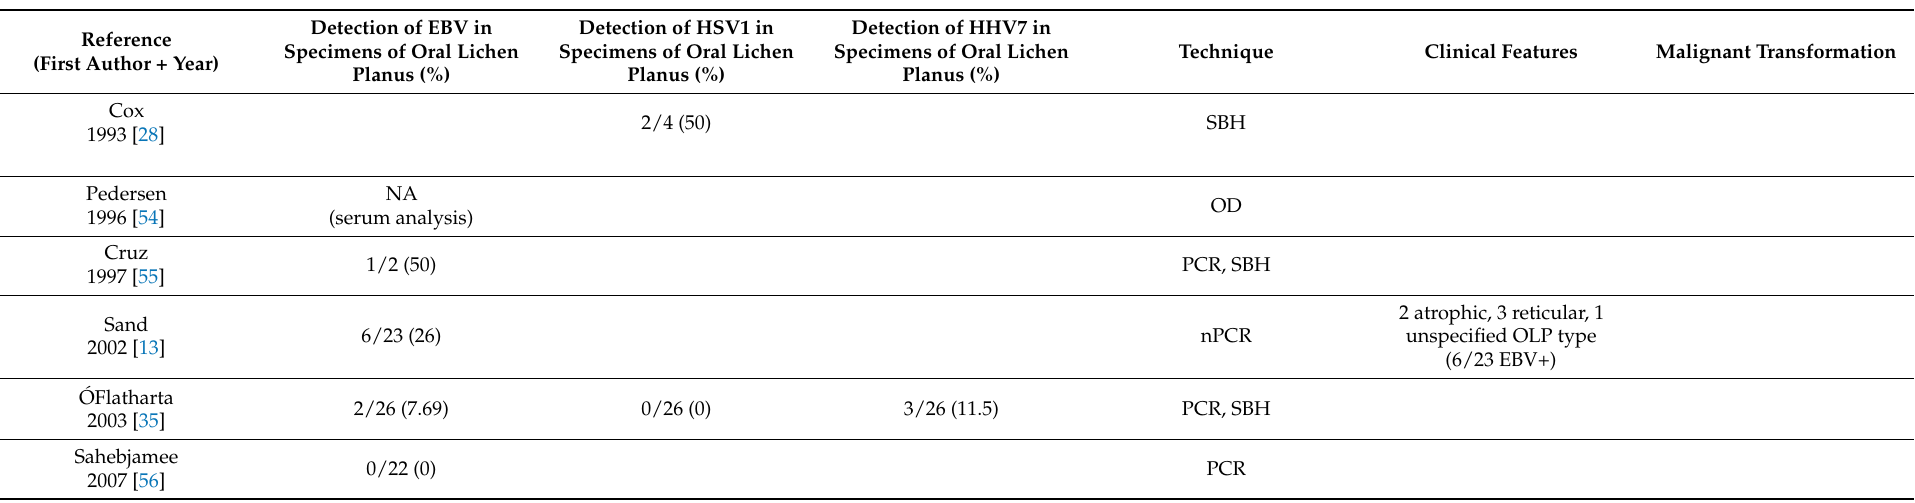
Table 3. Detection of other viruses, included in the review, in OLP